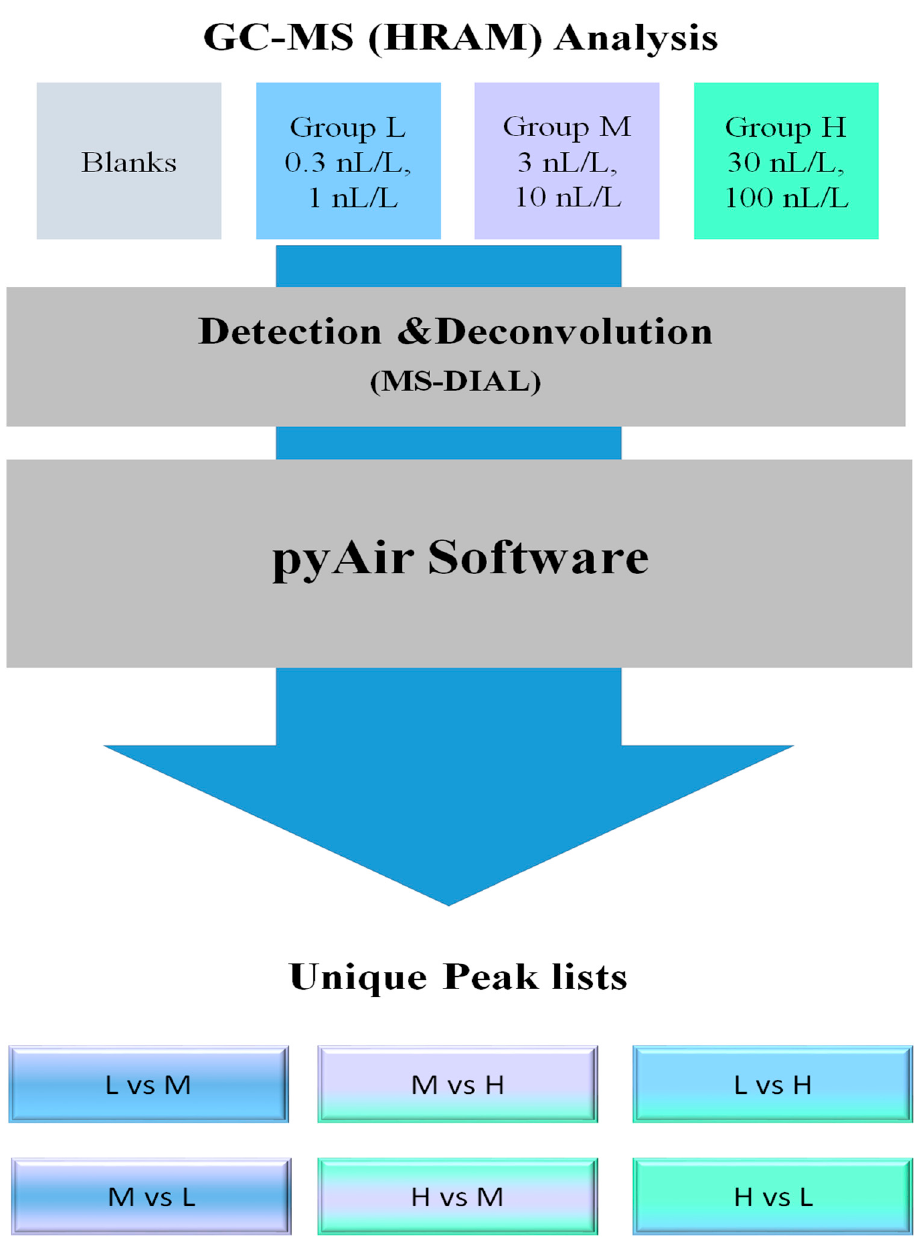
Figure 4. Data processing pipeline for finding biomarkers in breath analysis. The first step is analysis using GC-MS-HRMS. The second step is detection and deconvolution of the peaks using MS-DIAL. The third step is using pyAir to find unique peaks for each group.